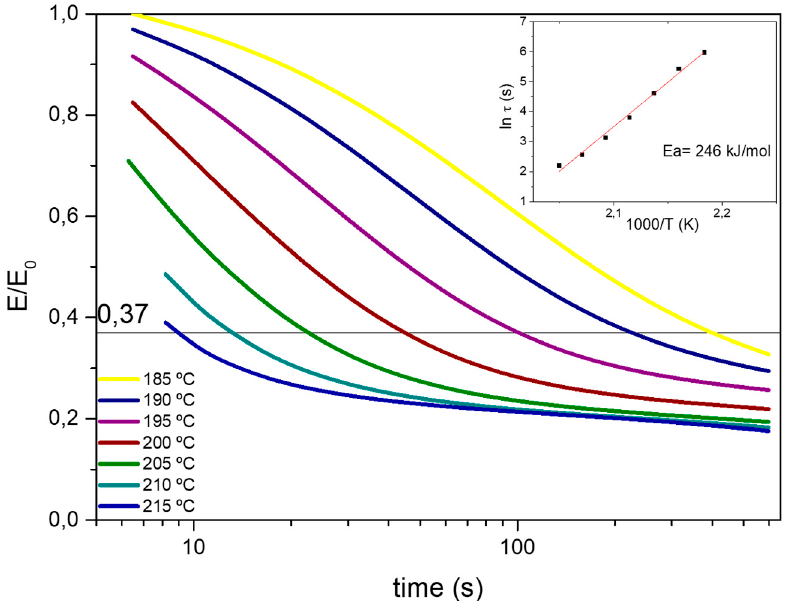
Figure 5. Normalized stress relaxation curves at different temperatures for aero grade epoxy vitrimer (Inset). Calculated activation energy ( Ea ) from stress relaxation test.